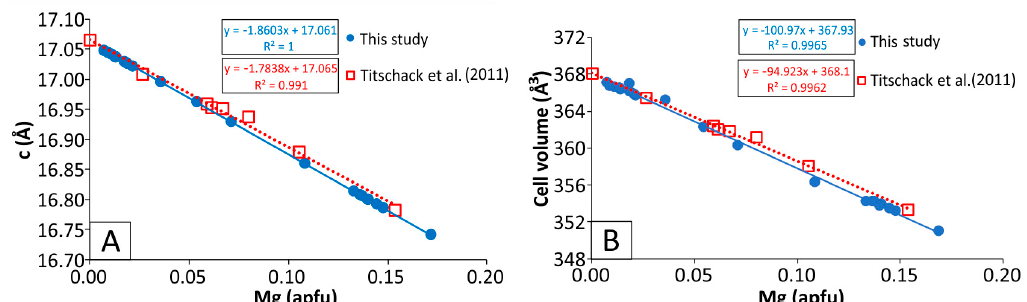
Figure 9. Comparing correlation of lattice parameters for magnesian calcite of this study (in blue) and of Titschack et al. [32] (in red). ( A ) Correlation between crystallographic axis c and molar fraction of MgCO 3 ; ( B ) Correlations between cell volume and molar fraction of MgCO 3 .